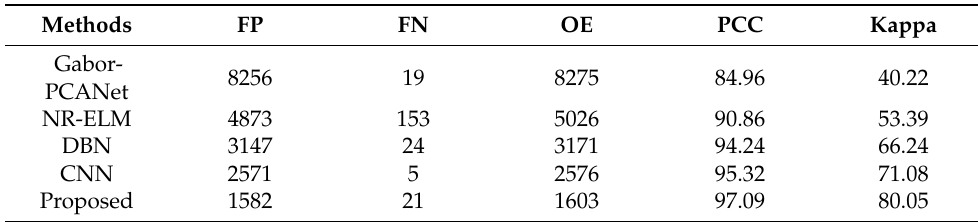
Table 2. Change detection result of the simulated synthetic aperture radar (SAR) dataset. CNN: convolutional neural network, FP: false-positives, FN: false-negatives, OE: overall error, and PCC: percentage correct